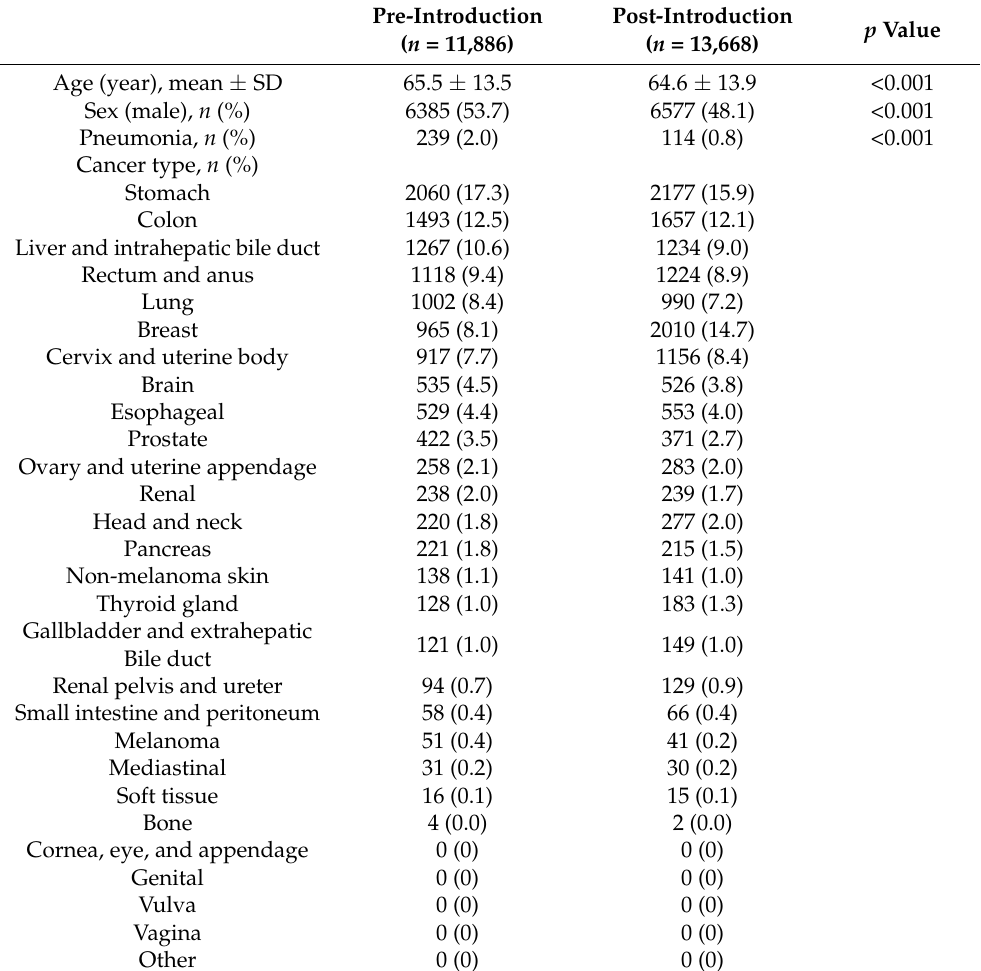
Table 1. Characteristics of Target group. Pre-introduction: before the introduction of